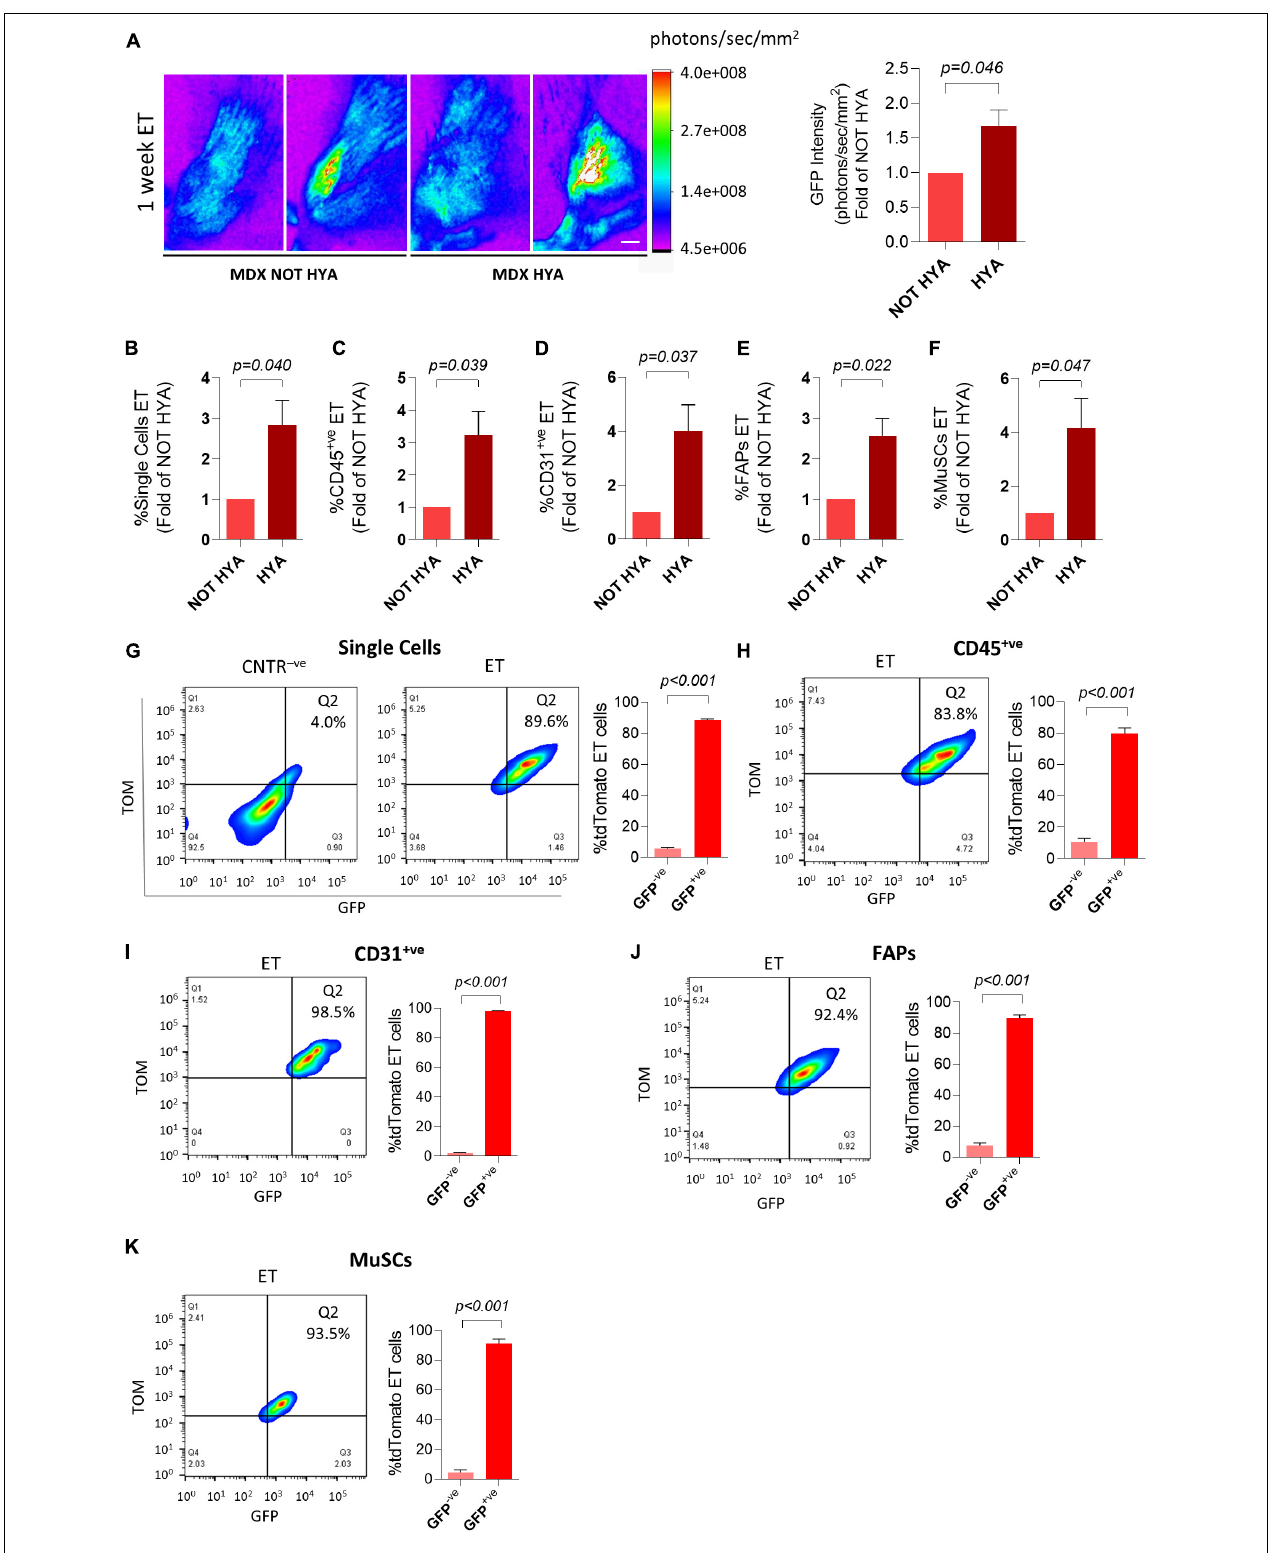
FIGURE 4 | Hyaluronidase pre-conditioning increases the efficiency of electroporation of mononucleated cells in dystrophic muscles. (A) Representative Bruker In Vivo Xtreme I images (left) and GFP intensity measurement (photons/sec/mm 2 ) (right) of TA muscles from ∼ 6 months-old mdx 4Cv (MDX) mice injected with hyaluronidase (HYA) or not injected (NOT HYA). 2 h after hyaluronidase injection TA muscles were injected with PBS (CNTR – ve ) or GFP plasmid (ET) and